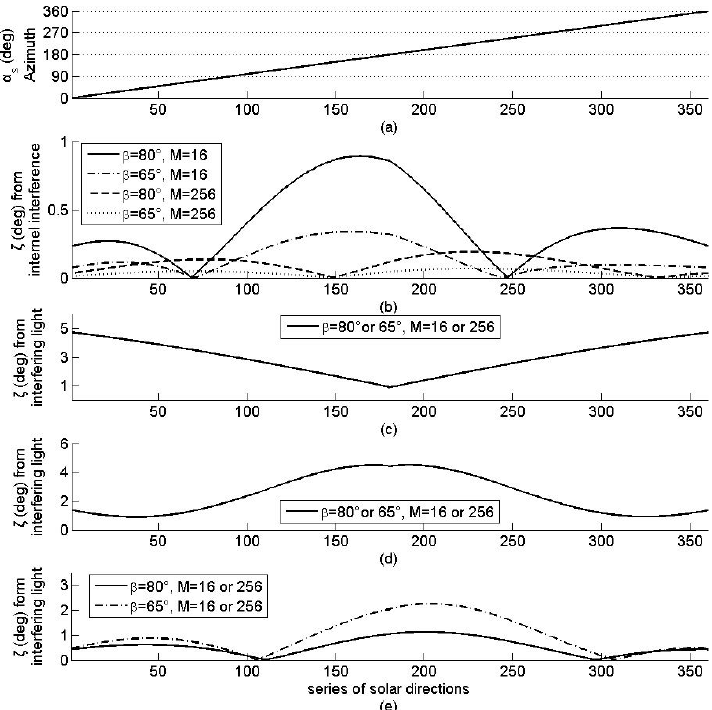
Figure 5. Solar elevation angle ( a ) and the error ζ in the elevation angle for four simulated arrays with different interference: ( b ) internal interference; ( c – e ) external interference caused by interfering light sources at positions 1, 2, and 3